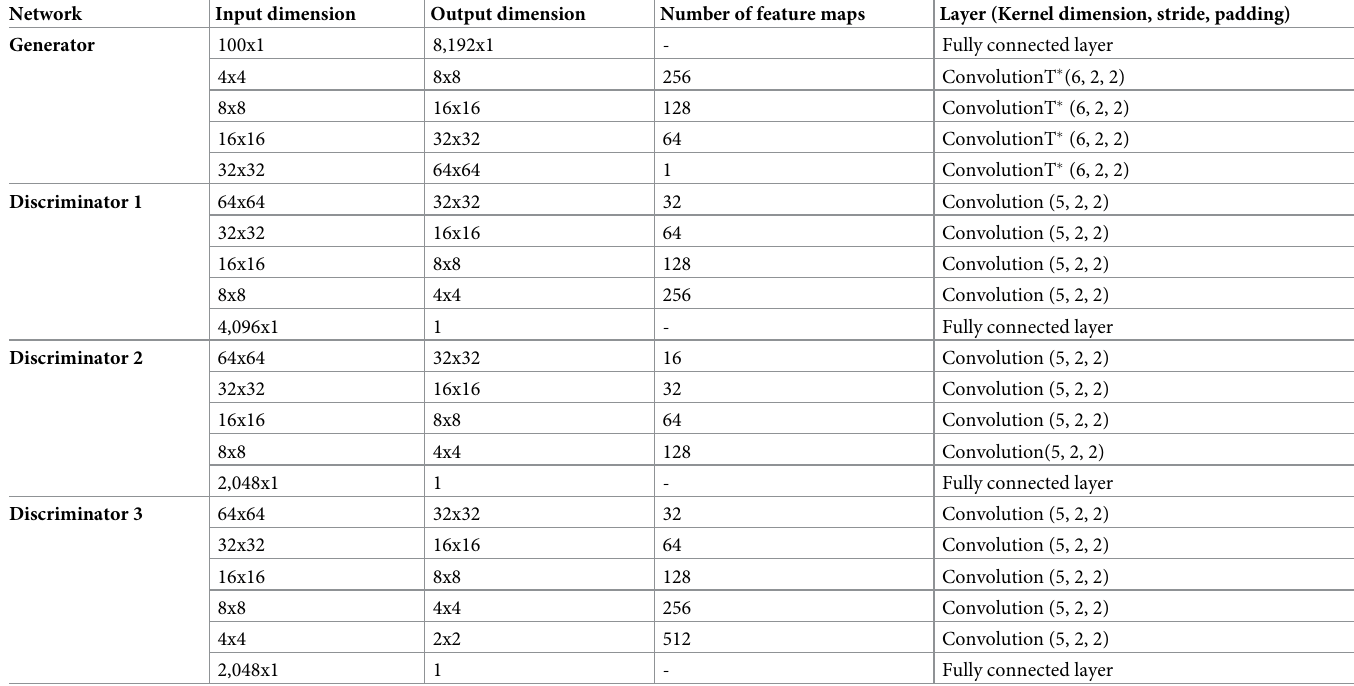
Table 7. Architecture of the generator and the three discriminators used in our Generative Multi Adversarial Network.